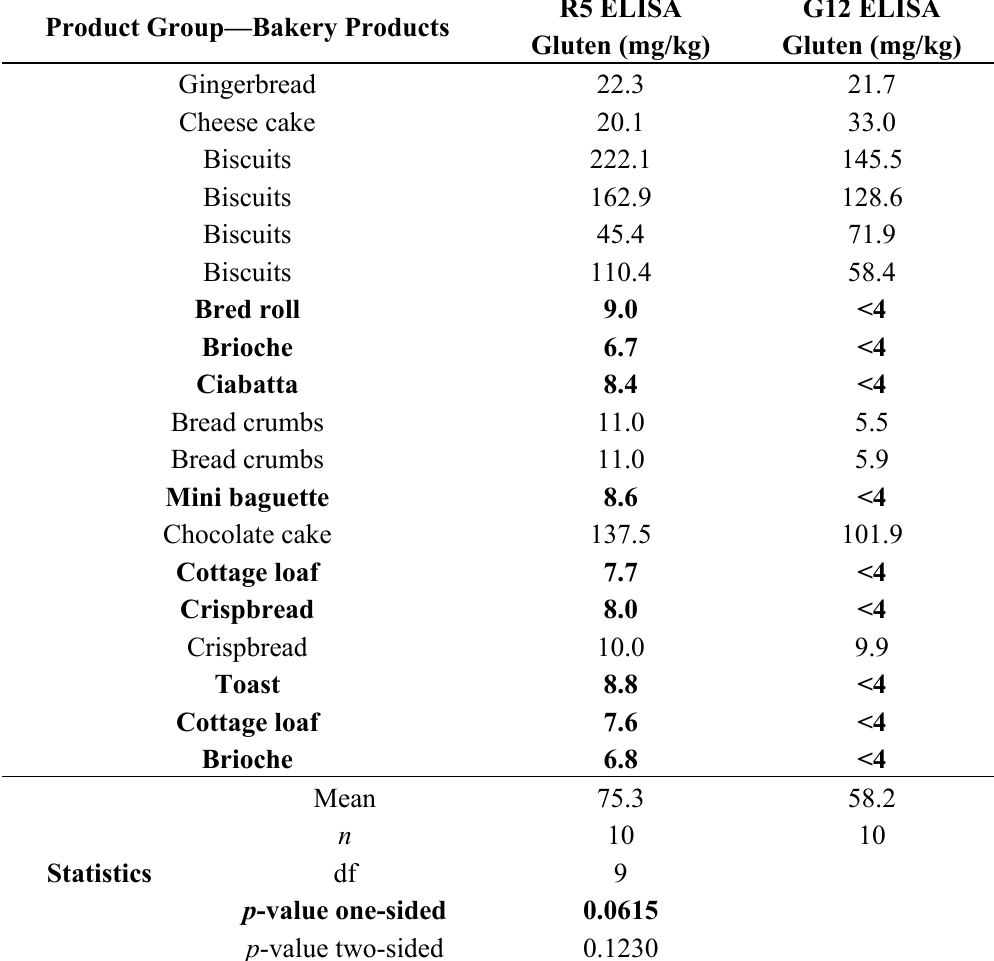
Table 4. Results of the bakery products group. Nine samples (highlighted in bold), which gave results below the LOQ for one or both methods, were excluded from the statistical analysis ( n = number of samples, df = degrees of